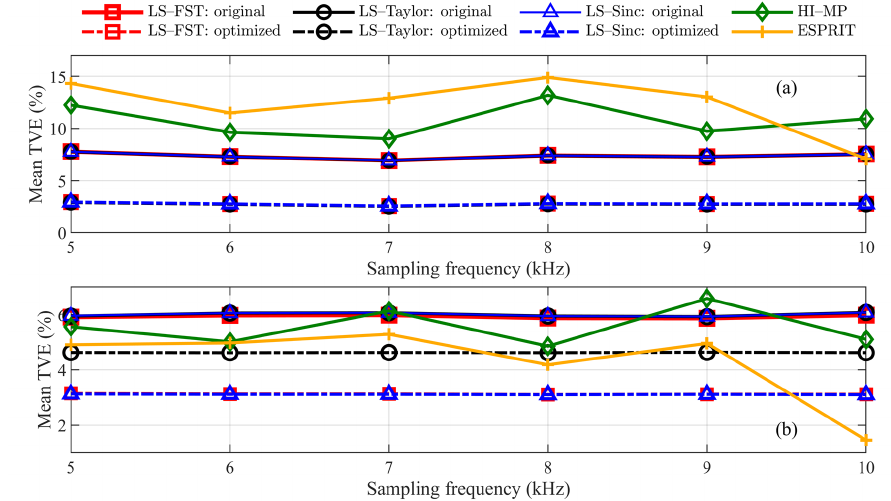
Figure 13. The mean TVE for ( a ) second and ( b ) thirteenth harmonic phasors of LS-FST, LS-Taylor, and LS-Sinc with and without the proposed optimization, as well as the HI-MP and ESPRIT methods under sampling frequency